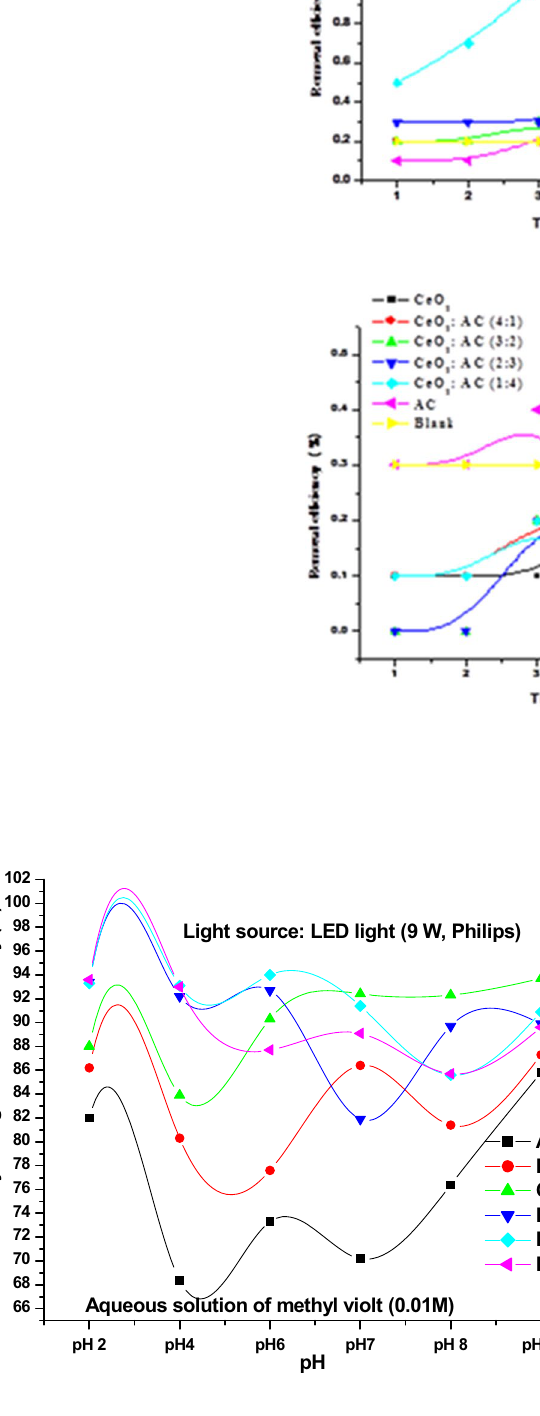
Fig. 8 Effect of pH on photocatalytic degradation efficiency of CeO